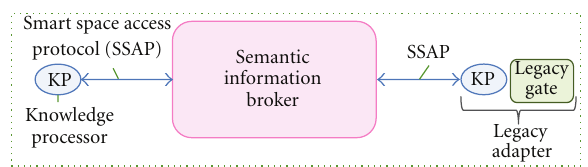
Figure 1: Smart M3 conceptual architecture the “smart space is in the